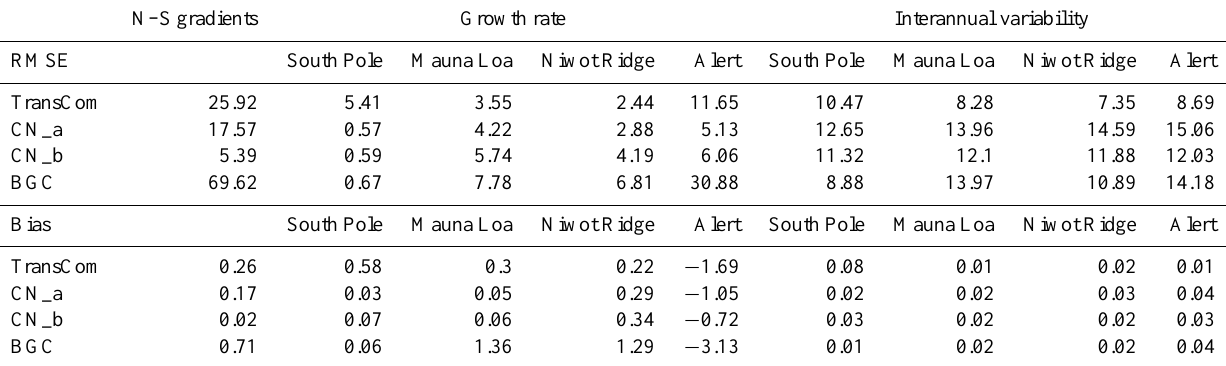
Table 4. Model performance statistics including the root mean square error (RMSE) and bias (ppbyr − 1 ). Bias is calculated as the absolute deviation of the mean between model simulations and